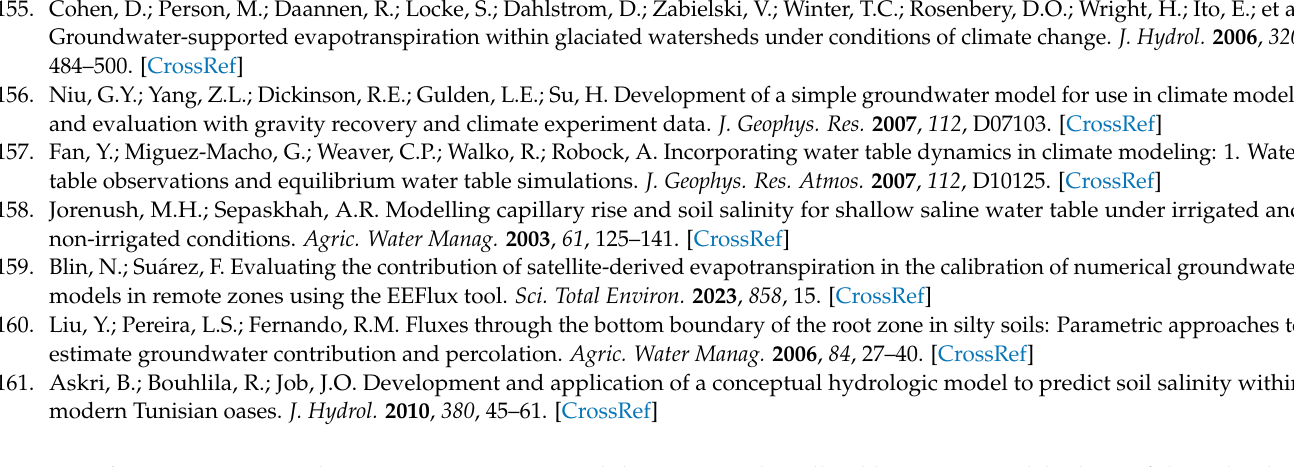
table observations and equilibrium water table simulations. J. Geophys. Res. Atmos. 2007 , 112 , D10125.